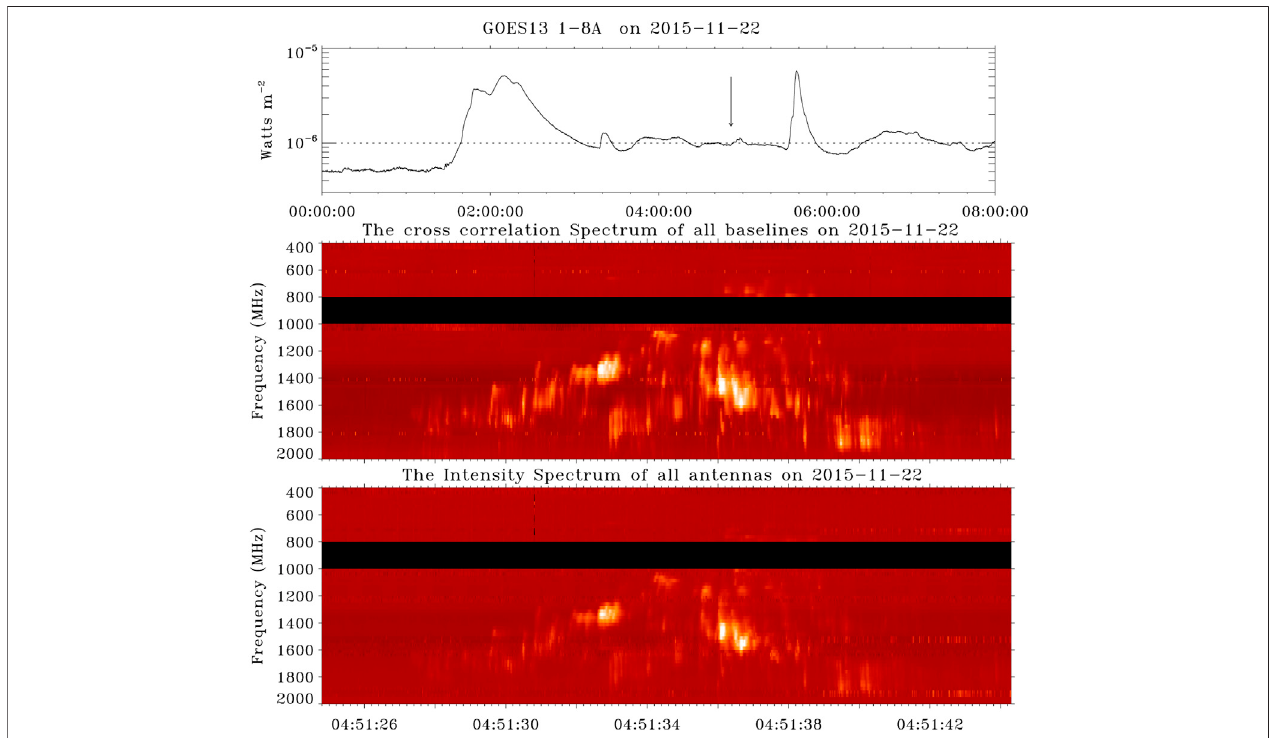
FIGURE 9 | Top panel: The GOES SXR pro fi le during 0 – 8 UT on 22 November 2015. The arrow indicates the moment where the radio burst fi ne structures occurred.Middlepanel:TheaveragedcrosscorrelationspectrumofallMUSER-Ibaselinesforaradioburst fi nestructureeventwithabout15 sdurationoccurredaround 04:51:35 UT. Bottom panel: The auto-correlation intensity spectrum of all MUSER-I